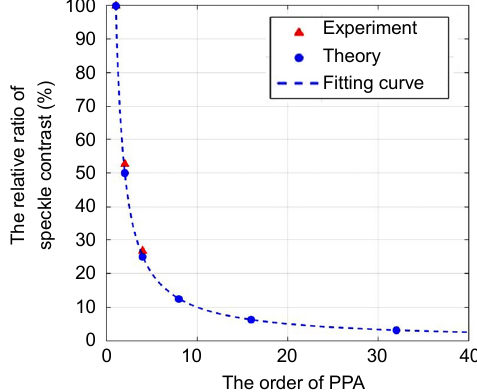
Fig. 7 | The relative ratio of speckle contrast is inversely propor- tional to the order of PPA.